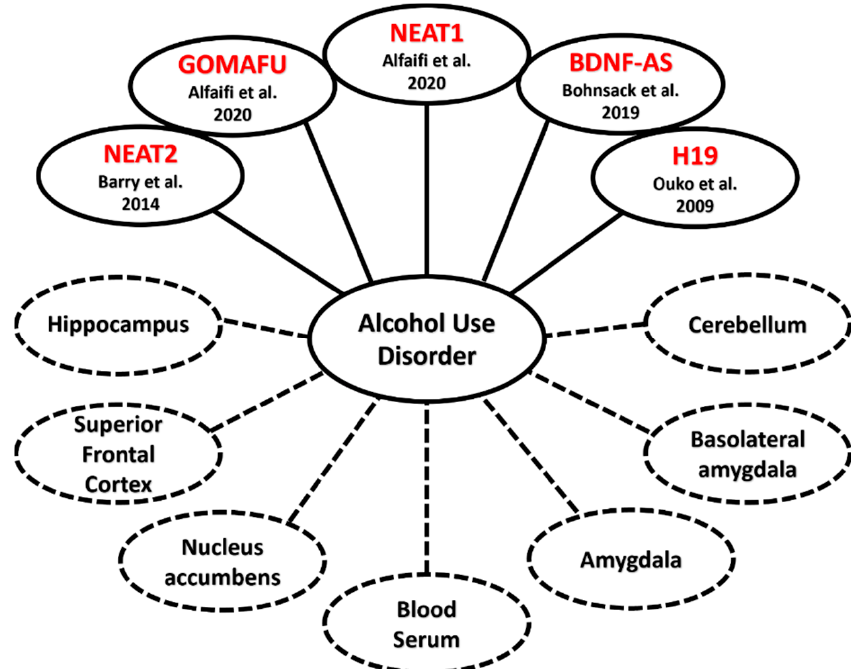
Figure 4. Linkages between lncRNA and AUD: lncRNAs contributing to the emergence of Alcohol Use Disorder (solid lines) and the diverse areas of the human body that samples were taken from (dotted lines), such as regions of the brain or blood serum [36,39,47,53,74–77].